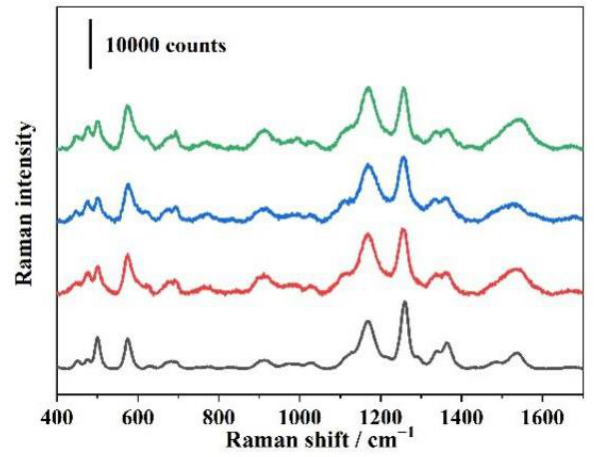
Figure 9. SERS spectra of TBA-MDA in sunflower seed oil (green line), lard (blue line), rapeseed oil (red line) and deionized water (black line). Real oil samples were prepared following processes in Section 2.5. TBA-MDA concentration was 10 − 7 M. Table 2. Recovery test of MDA in oil samples by spiking different concentrations of MDA.